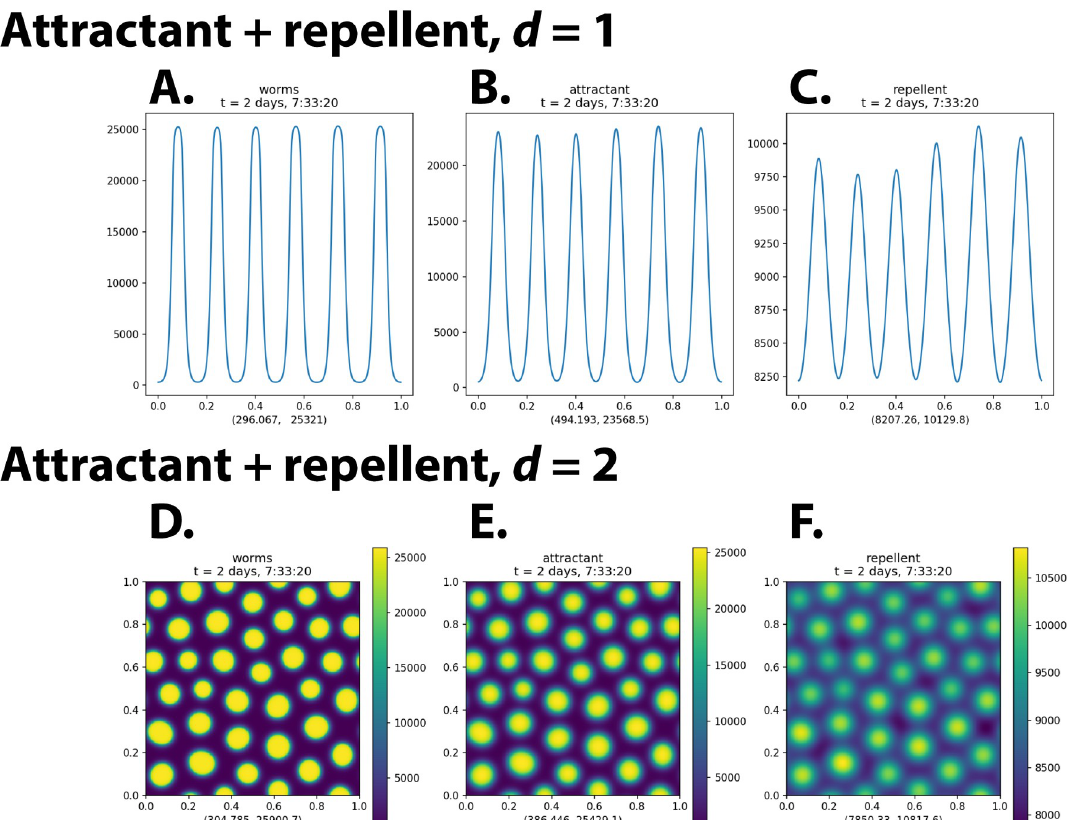
, and C, F show repellent a